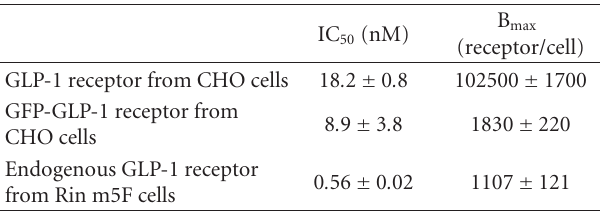
Table 1: E ff ect of GLP-1(7-36)amide on GLP-1 receptor binding sites from Rin m5F cells and CHO cells transiently expressing human GLP-1 receptor and GFP-GLP-1 receptor.